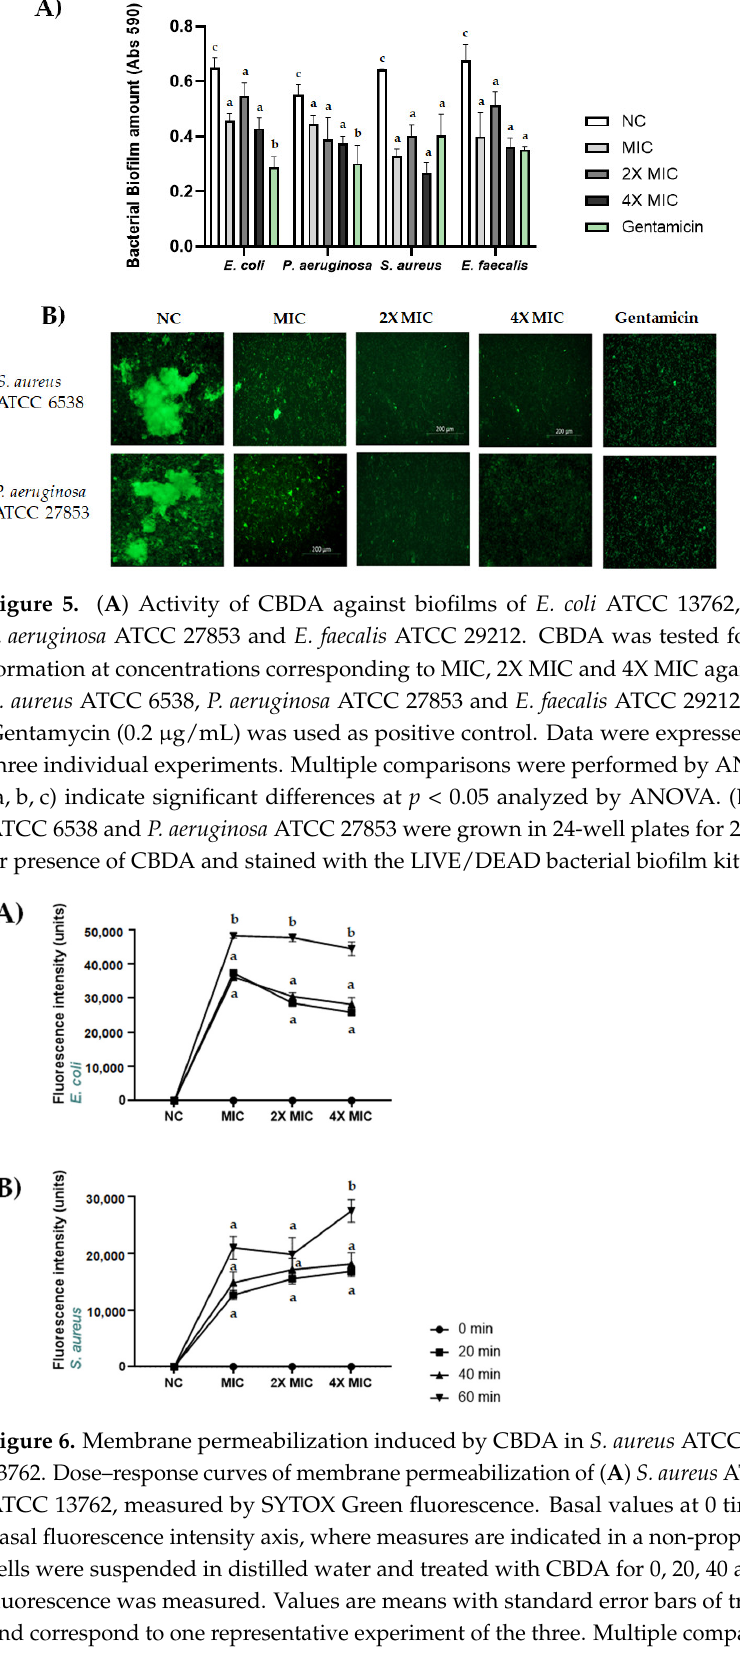
Figure 6. Membrane permeabilization induced by CBDA in S. aureus ATCC 6538 and E. coli ATCC 13762. Dose–response curves of membrane permeabilization of ( A ) S. aureus ATCC 6538 and ( B ) E. coli ATCC 13762, measured by SYTOX Green fluorescence. Basal values at 0 time are coincident with basal fluorescence intensity axis, where measures are indicated in a non-proportional scale. Bacterial cells were suspended in distilled water and treated with CBDA for 0, 20, 40 and 60 min, whereupon fluorescence was measured. Values are means with standard error bars of triplicate measurements and correspond to one representative experiment of the three. Multiple comparisons were performed by ANOVA. Different letters (a, b) indicate significant differences at p < 0.05 analyzed by ANOVA. NC: negative